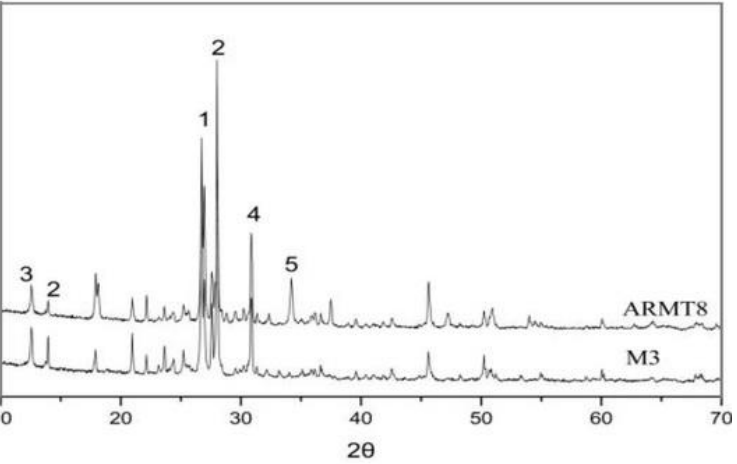
Figure 13. XRD result of M3 and after alkaline roasting at 500 °C for 150 min (ARMT8) [72].